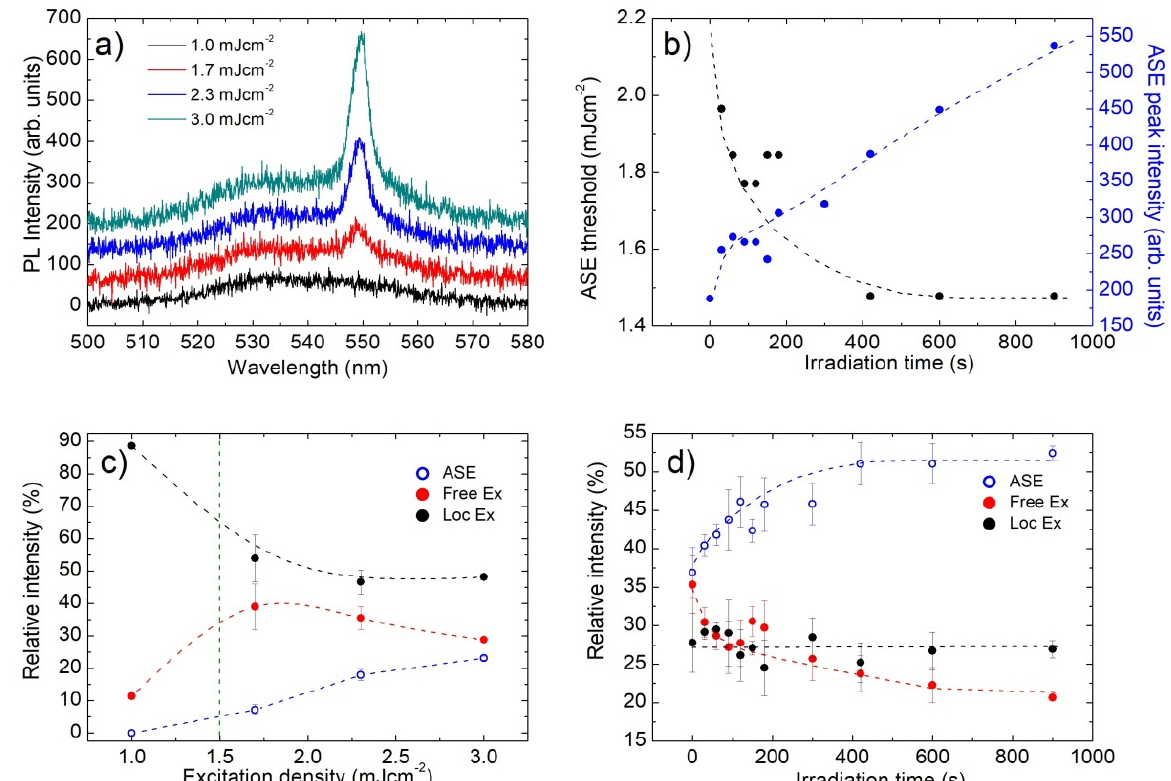
Figure 4. ( a ) PL spectra of sample B at the end of the irradiation process, as a function of the excitation density. The progressive appearance of ASE band about a wavelength of 550 nm is clearly visible; ( b ) ASE threshold (black dots) and ASE intensity at 3.0 mJ cm − 2 recorded every 30 s of CW irradiation in air, showing a progressive threshold decrease and ASE intensity increase; ( c ) excitation density dependence of the relative contribution to the emission spectra of the ASE, free EXs and localized EXs bands (the lines are guides for the eyes); ( d ) irradiation time dependence of the relative contribution to the emission spectra of the ASE, free EXs and localized EXs bands (the lines are guides for the eyes).